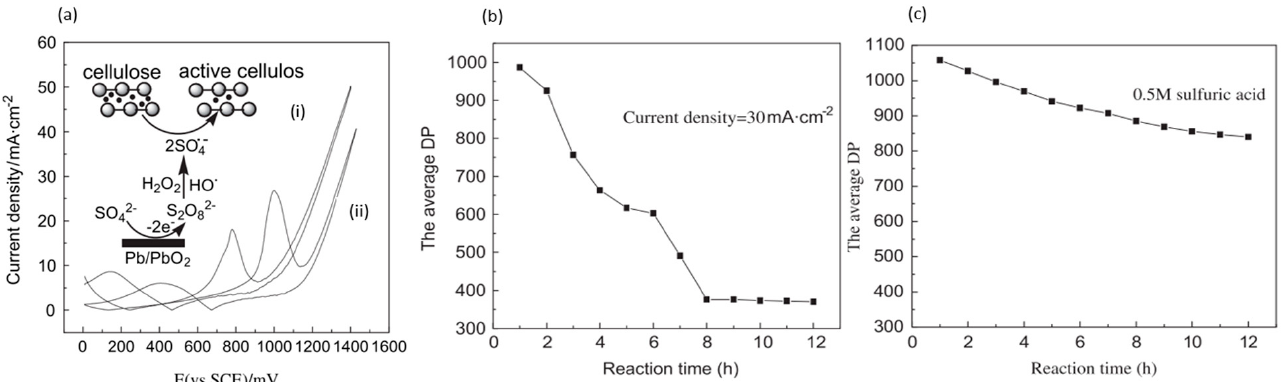
Figure 6. ( a ) CVs (vs. SCE) of 0.5 M sulfuric acid (i) and 0.5 M sulfuric acid with 10 g/L cellulose (ii). ( b ) Decrease in DP over time at 30 mA/cm 2 . ( c ) Decrease in DP over time without applied current. Reprinted with permission from Ref. [42]. Copyright 2011, Polymer Degradation and Stability.